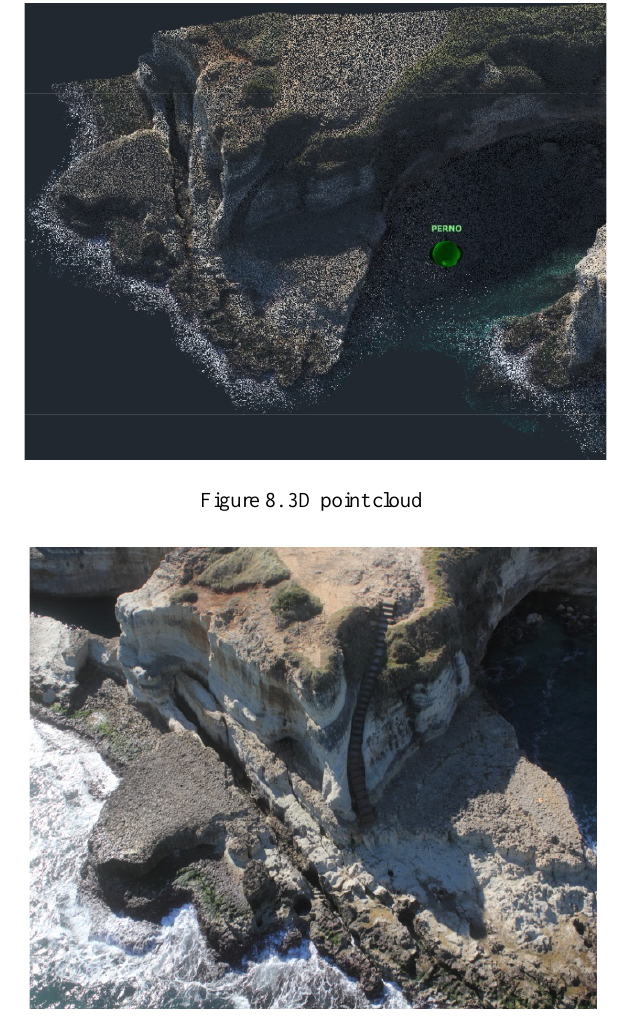
Figure 9. 3D model from LAS data